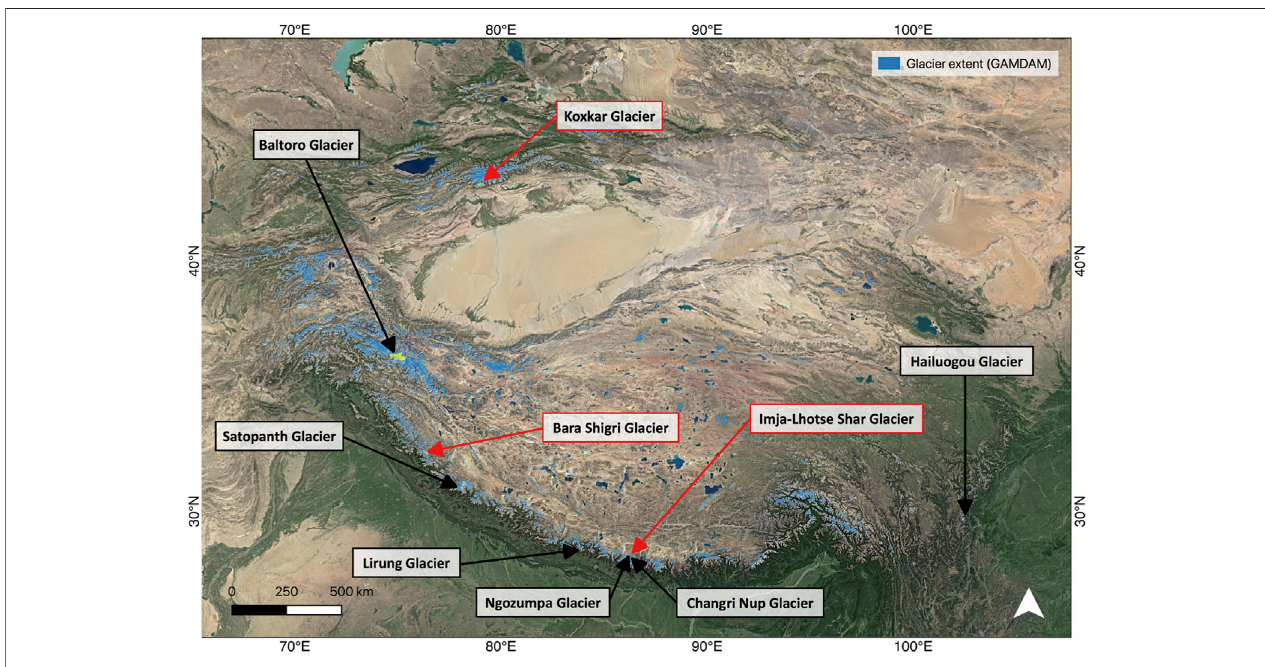
FIGURE 1 | The six studied glaciers (black outline and arrow) and the three validation glaciers (red outline and arrow), in the context of the glaciated areas of High Mountain Asia, according to the Glacier Area Mapping for Discharge from the Asian Mountains (GAMDAM) inventory (Sakai, 2019). Base map: Google Satellite Maps.